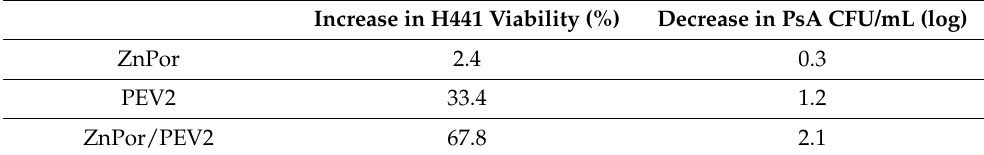
Table 1. Determination of Synergistic Behavior following 4 µ g/mL ZnPor and PEV2